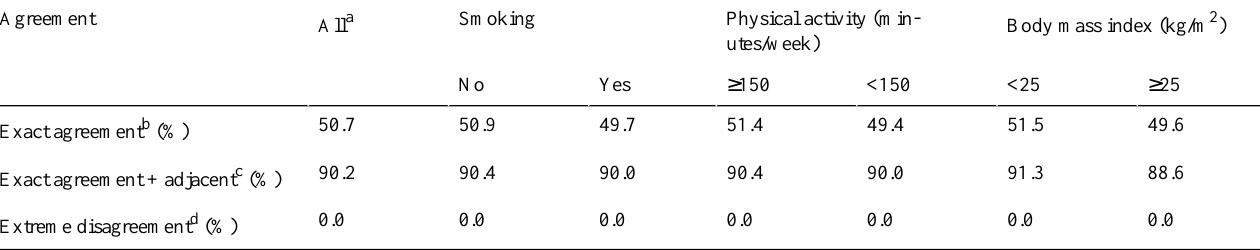
Table 5. Cross-classification analysis derived from the electronic 12-hour dietary recall app versus the food frequency questionnaire for categories of food group consumption and strata: smoking: no and yes; physical activity (minutes/week): ≥ 150 and <150; and body mass index (kg/m 2 ): <25 and ≥ 25. Comparison of the electronic 12-hour dietary recall app versus the food frequency questionnaire.